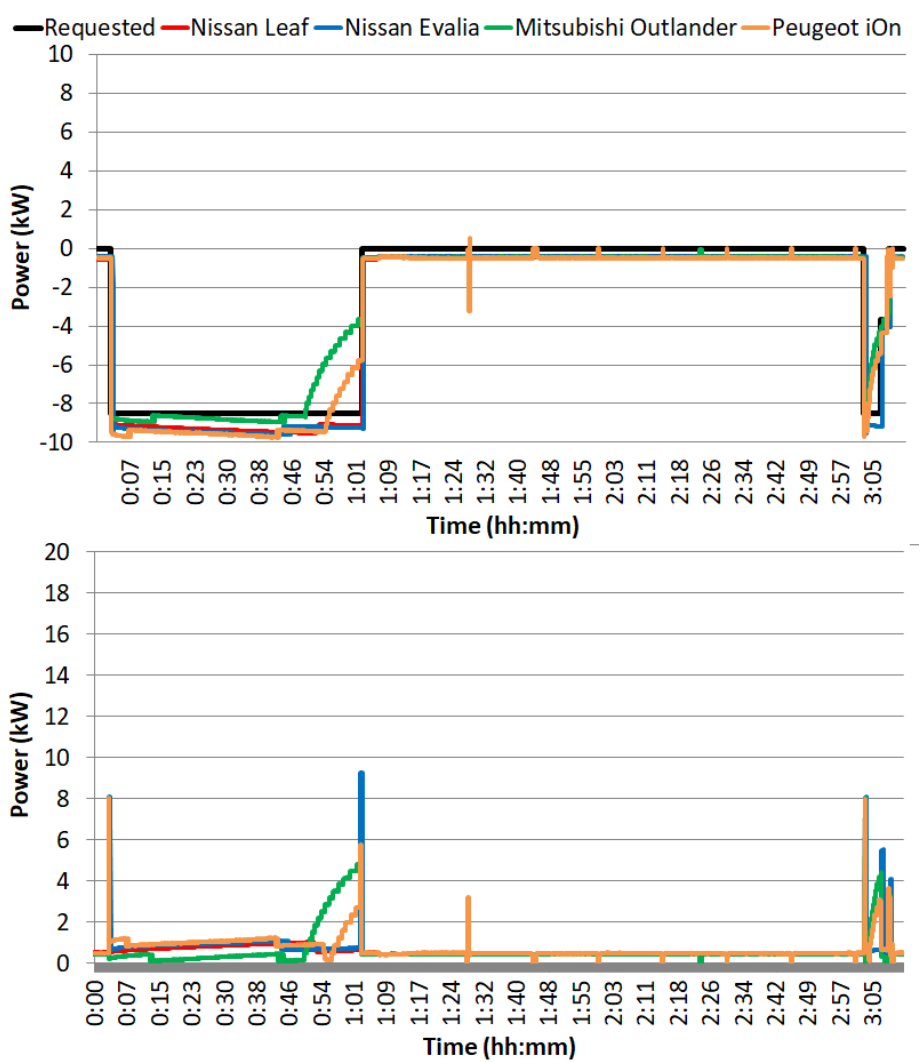
Figure 5. Parker service—Marginal Emission Factor, top : requested and provided power for service, bottom : absolute difference between requested and provided